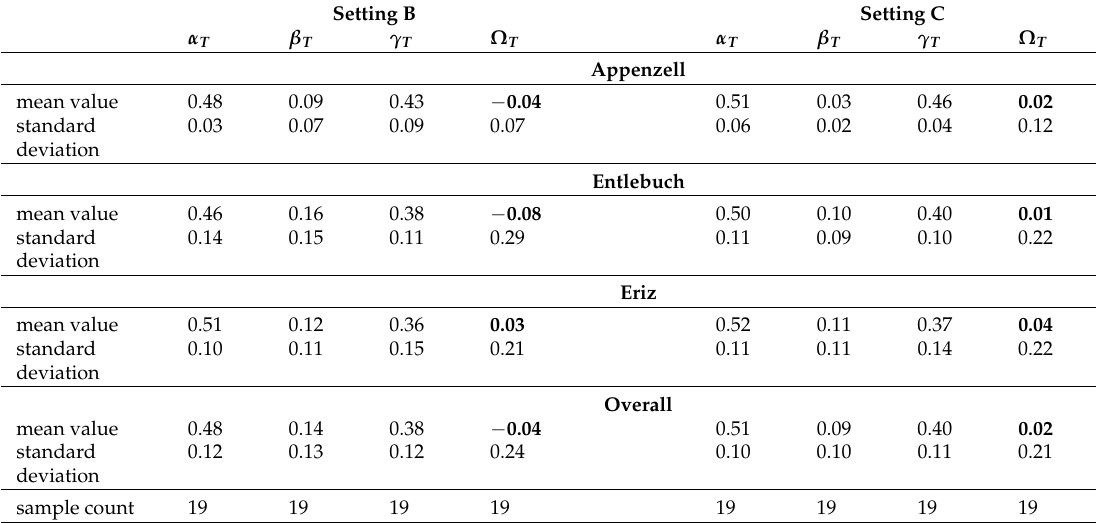
Table 4. Evaluation results for settings B and C . α T denotes the simulation performance related to the overlap (a value of 1 corresponds to full coverage of simulation/observed). β T is a performance measure of the underestimation, whereas γ T shows the overestimation performance of the considered simulation. The overall performance is specified by Ω T . All values are calculated based on Equation (6), following the procedure described in Heiser et al. [43]. Setting B Setting C α T